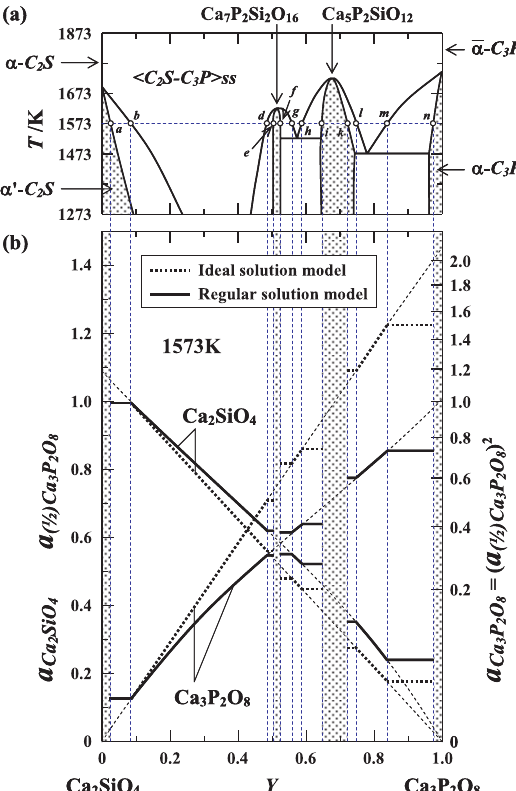
Fig. 3: (a) Phase diagram of the pseudo-binary system Ca 2 SiO 4 - Ca P O . (b) Activities of Ca 3 2 8 substitution ratio Y